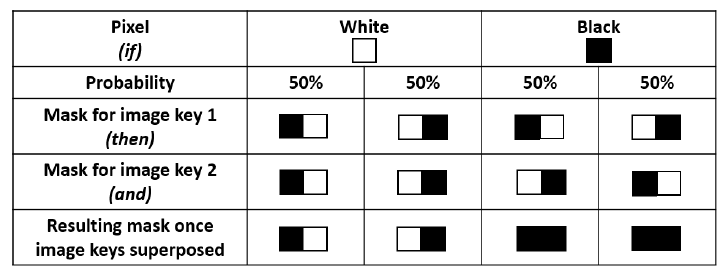
Figure 1. A conventional visual cryptography scheme in a security context.